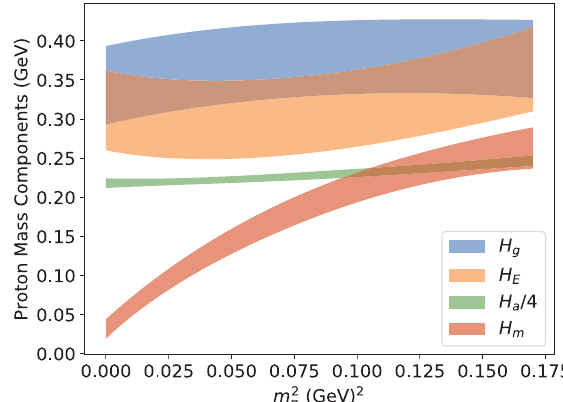
Figure 4. Proton mass decomposition from Ref. [4] against the pion mass squared. H g is the gluon field energy, H E is the quark energy, H a is the anomaly term, and H m is the quark